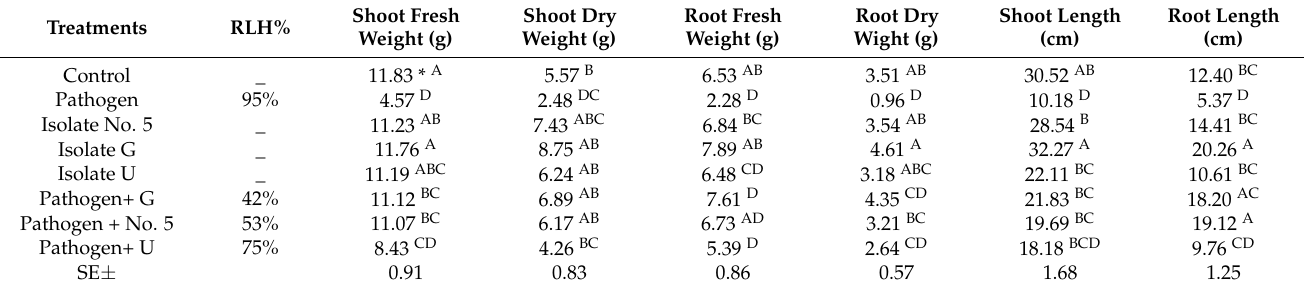
Table 1. The inhibitory effects of Actinomycetes isolates against Rhizoctonia solani (AG1-IA) causing rice sheath blight disease under glasshouse condition. Isolate U showed smaller effects on the fresh and dry weight than the other two isolates. According to the results, isolate G was the most effective isolate against rice pathogen. Different letters represent significant changes.